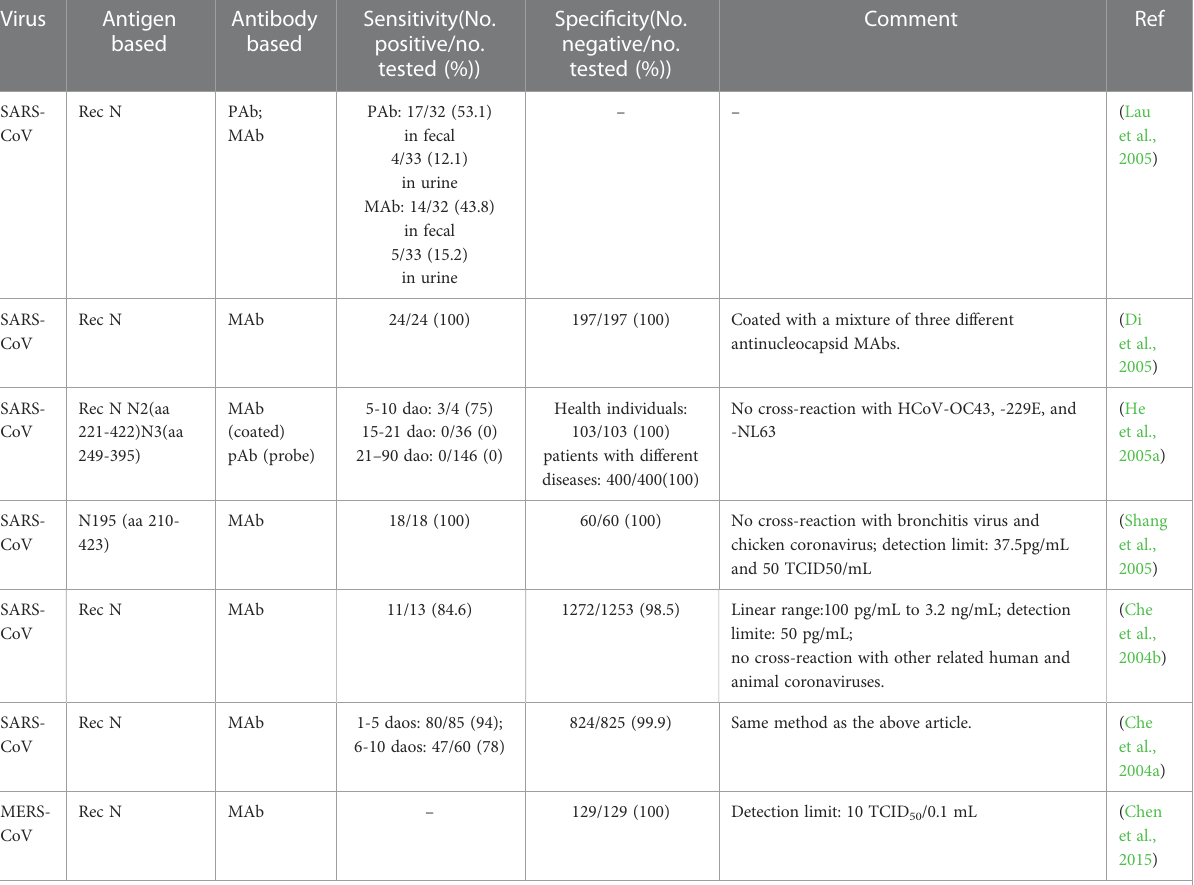
TABLE 2 ELISA for antigen detection validated by clinical